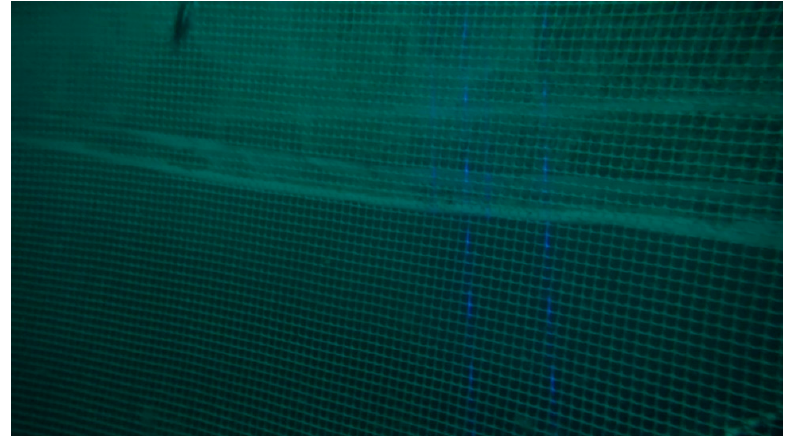
Figure 8. A picture taken at t = 650 s, where the triangulation distance disagrees with the DVL distance. The double net pen net in the upper part of the image confuses the DVL. Four laser lines are visible, two from each net.